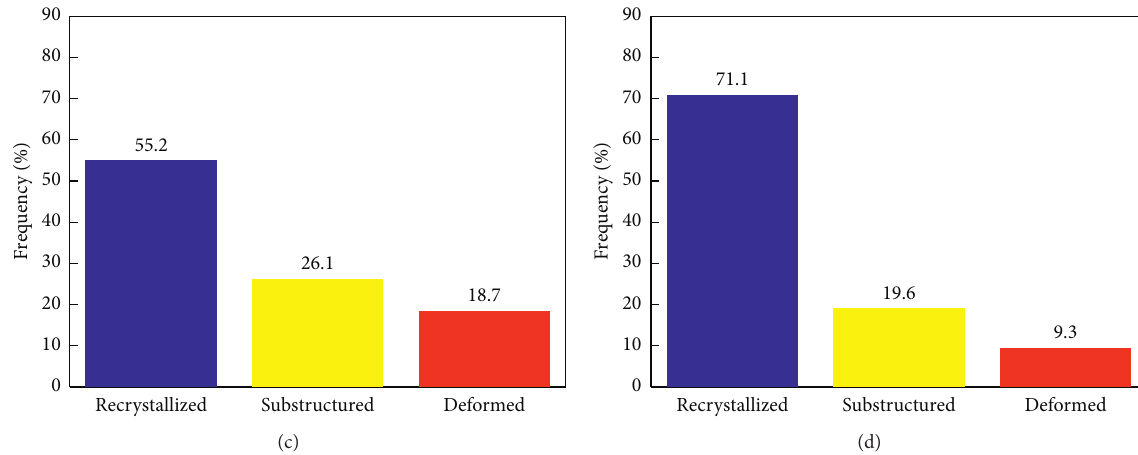
Figure 11: Frequencies of different types of grains of (a) MYZ, (b) MYZC, (c) MYZN, and (d) MYZCN extruded